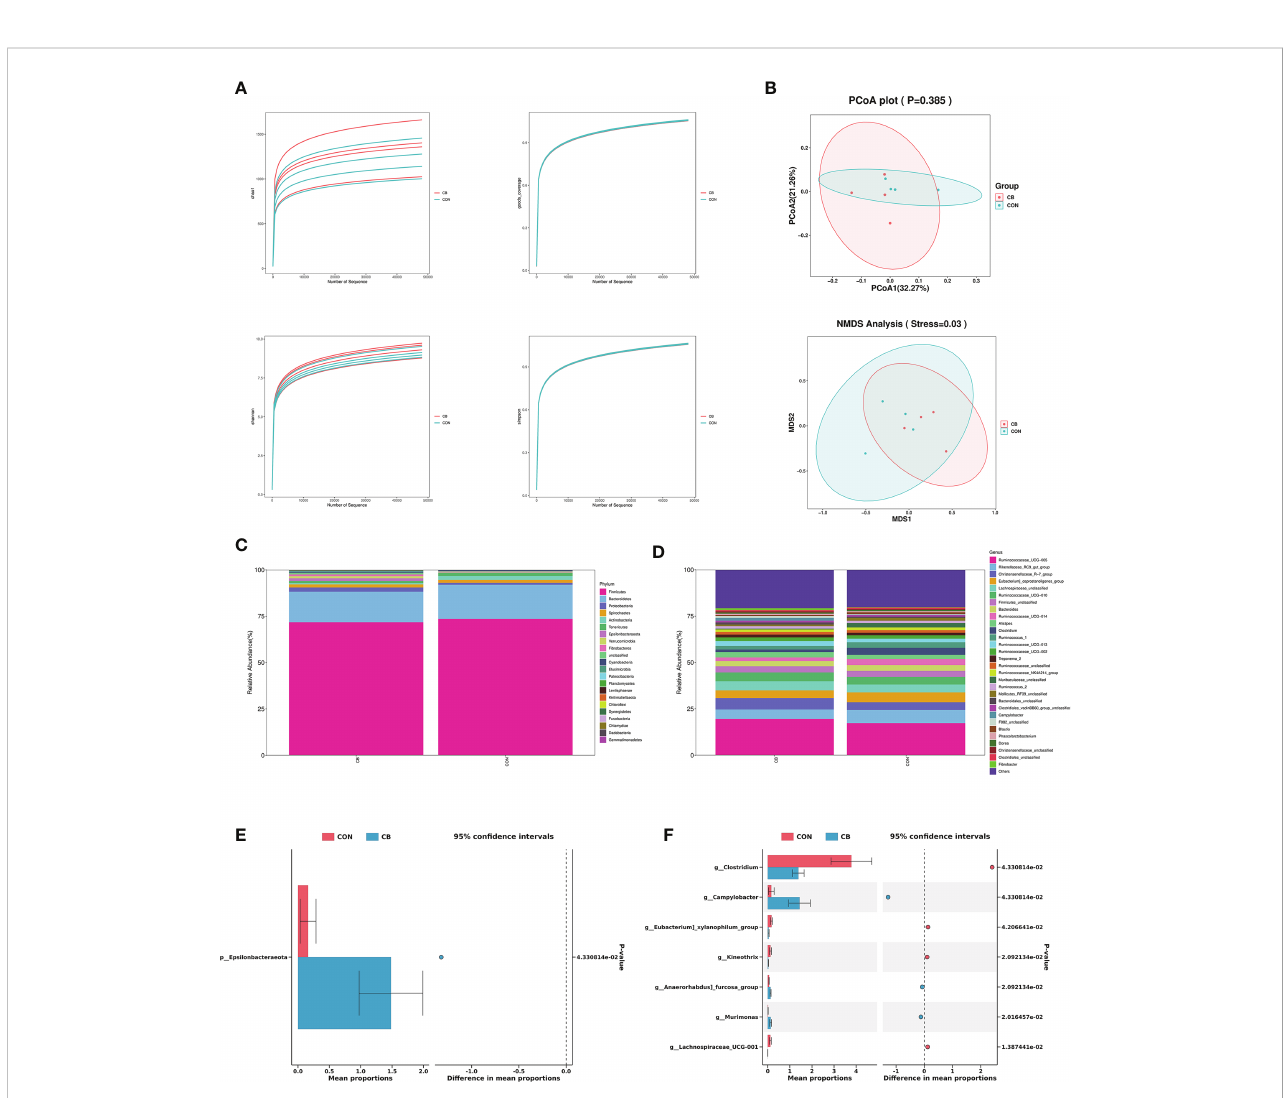
FIGURE 5 Effects of C. butyricum on rectal microbial diversity and richness in goats. (A) Alpha diversity: Chao 1, goods coverage, Shannon and simpson. (B) Beta diversity: PCoA and NMDS analysis. (C) The relative abundance of phylum level. (D) The relative abundance of genus level. (E) Signi fi cant difference in phylum level. (F) Signi fi cant difference in genus level.